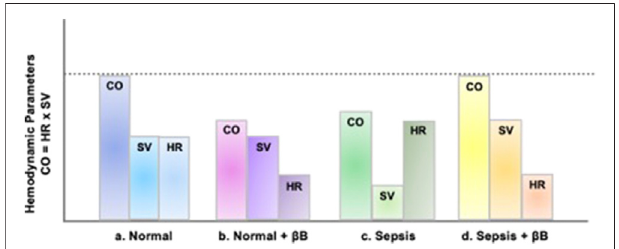
FIGURE 2| Hemodynamic effectsof sepsis and β -Blockade. In panel A, the strokevolume (SV) andcardiac output (CO),stroke volume (SV),and heart rate (HR) of a normal, healthy individual are presented. In panel B, due to the negative inotropy associated with β B, which causes reduced HR, the overall CO is reduced despite normal SV. In panel C, sepsis results in tachycardia, due to excessive sympathetic activation. This increase in HR does not allow for adequate ventricular fi lling causing a decrease in CO secondary to a decrease in SV. In panel D, given that venous return (i.e., preload) is adequate, then β B-induced HR reduction allows for more left ventricular fi lling time, subsequently decreasing afterload and increasing SV enough to overcome decreased HR and improved CO.